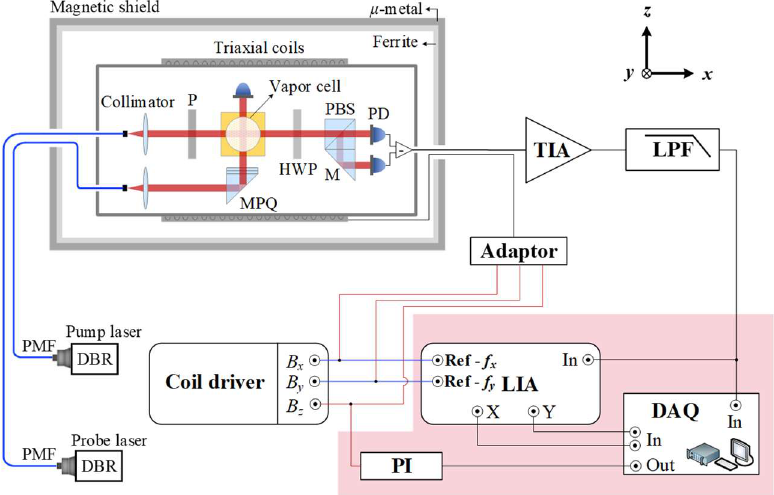
Figure 2. Experimental setup. PMF: polarization-maintaining fiber. P: polarizer. MPQ: M (mirror)+P+QWP (quarter-wave plate). HWP: half-wave plate. PD: photodetector. PBS: polarized beam splitter. TIA: trans-impedance amplifier. LPF: low-pass filter. LIA: lock-in amplifier. PI: proportional-integrative control modules. DAQ: data acquisition system.